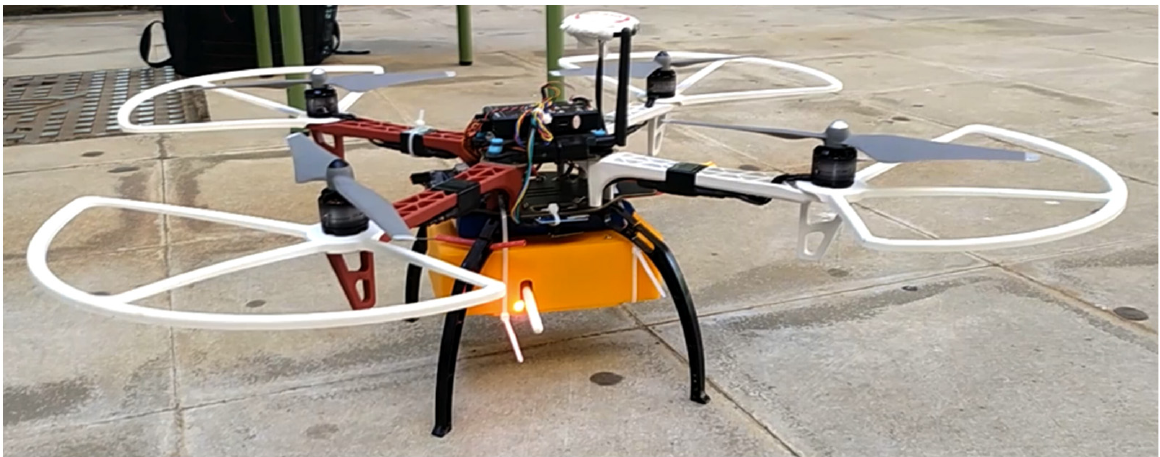
Figure 5. Integration of LoRa communication in the UAV.